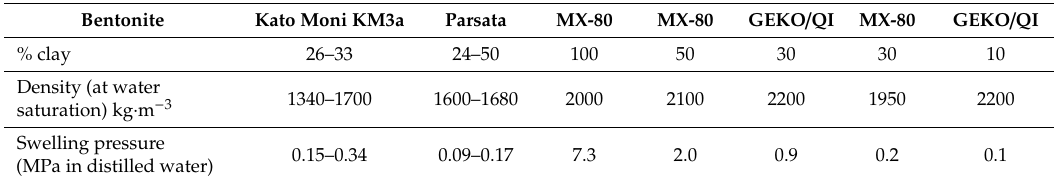
Table 5. Comparison of physical parameters for the Kato Moni and Parsata natural bentonites and MX-80 industrial bentonite and mixtures of crushed rock and montmorillonite-rich clay (data for MX-80 and GEKO industrial bentonites from